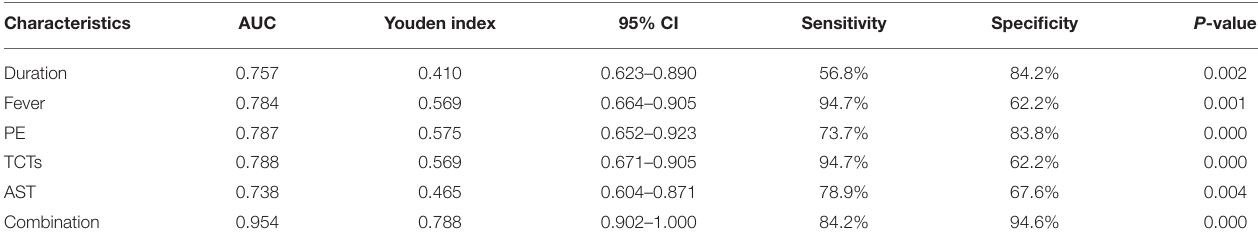
TABLE 7 | ROC analysis of duration, fever, PE, TCTs, and AST.